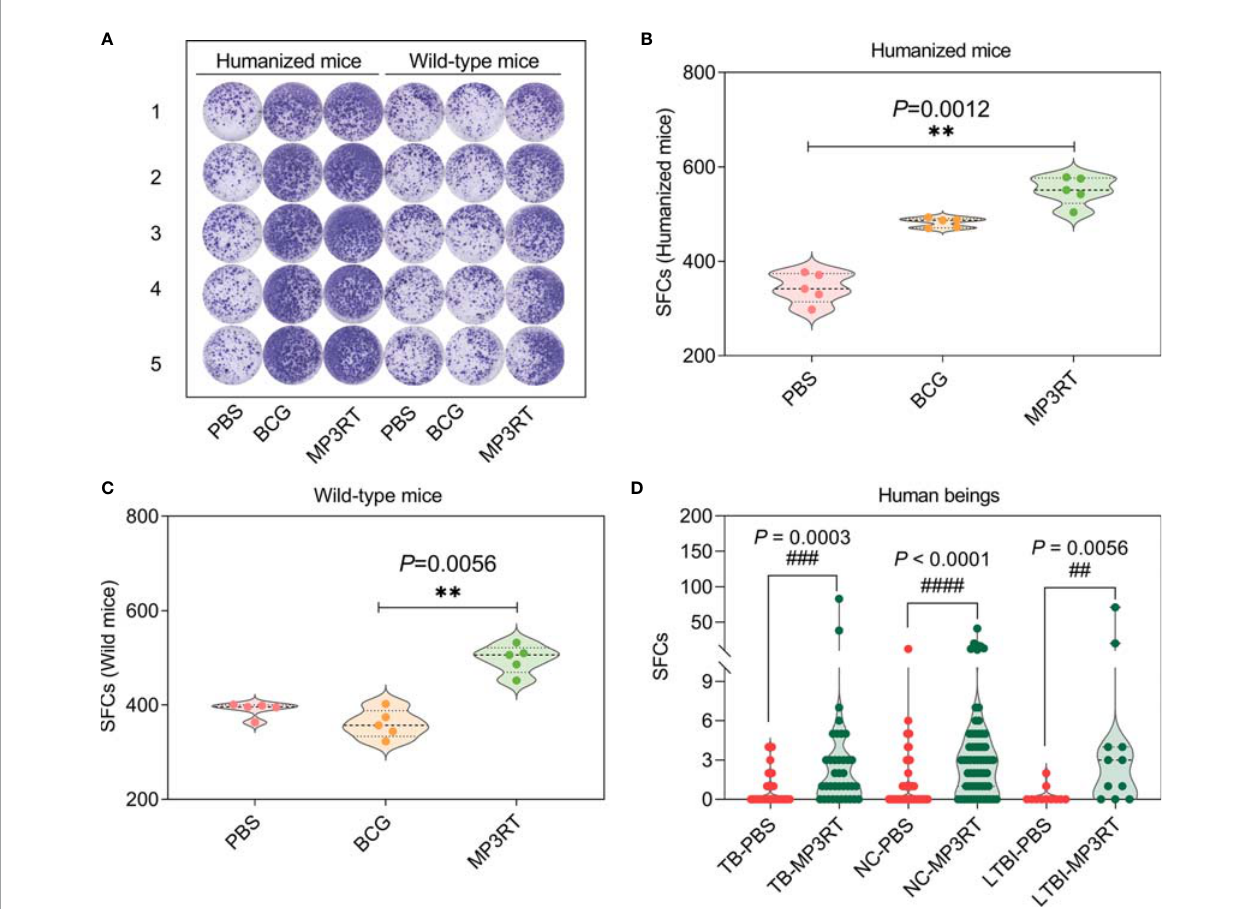
FIGURE 6 | IFN- g + T lymphocytes detection with ELISPOT. The MP3RT vaccine was used to stimulate the PBMCs collected from humanized mice or wild-type mice vaccinated with PBS, BCG, and MP3RT in vitro (A) . The number of IFN- g + T lymphocytes (showed as SFCs) in humanized mice (B) and wild-type mice (C) were determined with a mouse ELISPOT kit. The data were analyzed with a one-way analysis of variance (ANOVA) or Kruskal-Wallis test according to the data normality and homogeneity of variances. All data were shown as mean + SEM ( n = 5). P < 0.05 was considered signi fi cantly different. **, P < 0.01. Furthermore, the number of IFN- g + T lymphocytes in PBMCs collected from TB patients, LTBI volunteers, and normal controls (NC) were stimulated with the MP3RT vaccine in vitro . (D) The number of IFN- g + T lymphocytes were determined with a human ELISPOT kit. The data were analyzed with the Unpaired t -test or nonparametric test (Mann Whitney test) according to the normality. All data were shown as mean + SEM ( n = 37, 11, and 62 in TB patients, LTBI volunteers, and normal controls, respectively). P <0.05 was considered signi fi cantly different. ## P < 0.01; ### P <0.001; #### P <